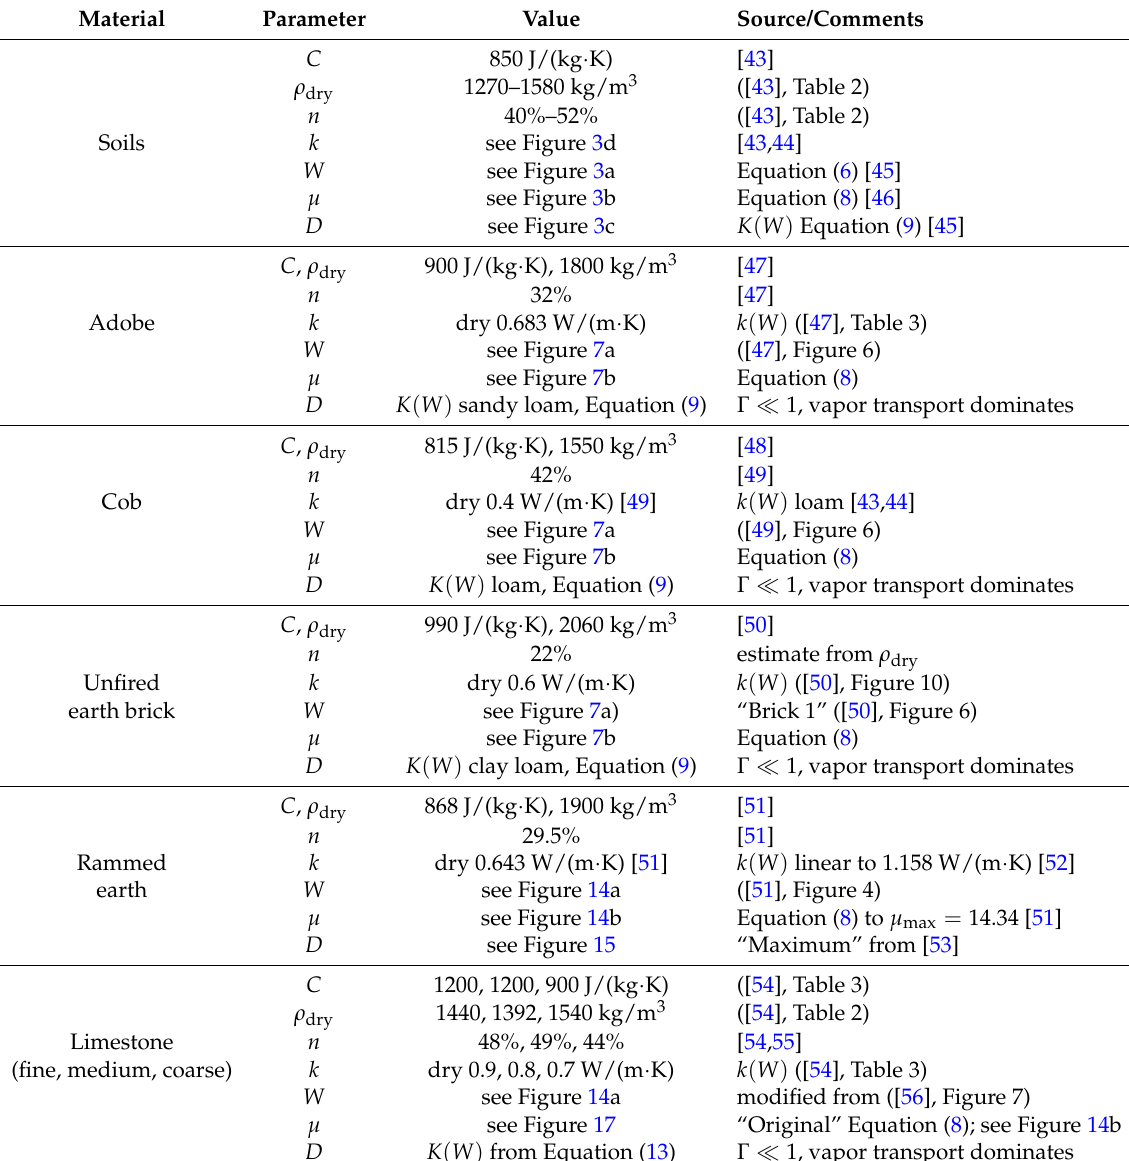
Table 2. Parameter values and sources; Sections 3.1–3.6 contain further